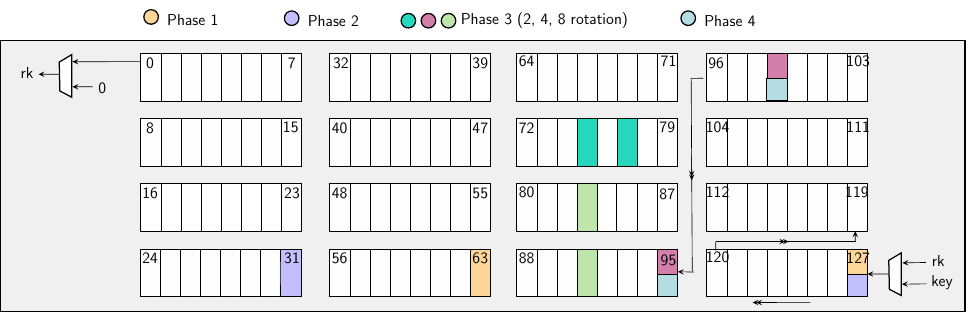
Figure 7: 128-cycle, bit-serial GIFT ∗ key schedule implementation using five